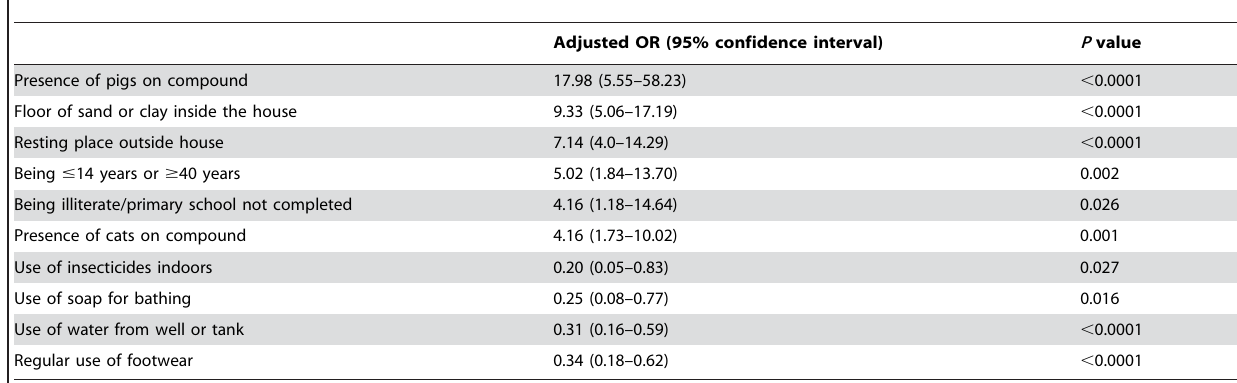
Table 2. Multivariate logistic regression analysis of factors associated with tungiasis.